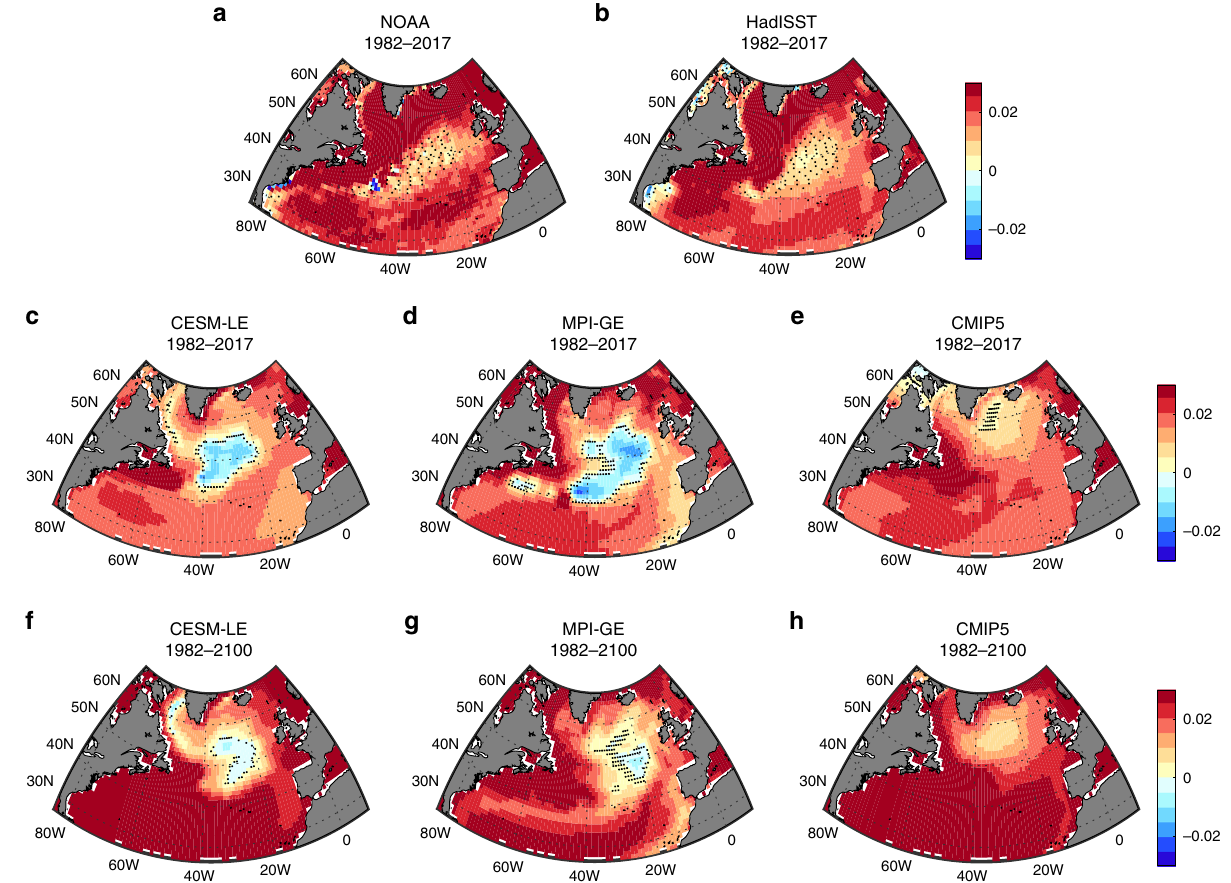
Fig. 1 Annual mean sea surface temperature trends (Kyr − 1 ). The 1982 – 2017 sea surface temperature trends from satellite-based observations in a NOAA, and b HadISST. The 1982 – 2017 simulated sea surface temperature trends from the mean of the c Community Earth System Model Large Ensemble (CESM-LE), d Max Planck Institute for Meteorology Grand Ensemble (MPI-GE), and e Coupled Model Intercomparison Project Phase 5